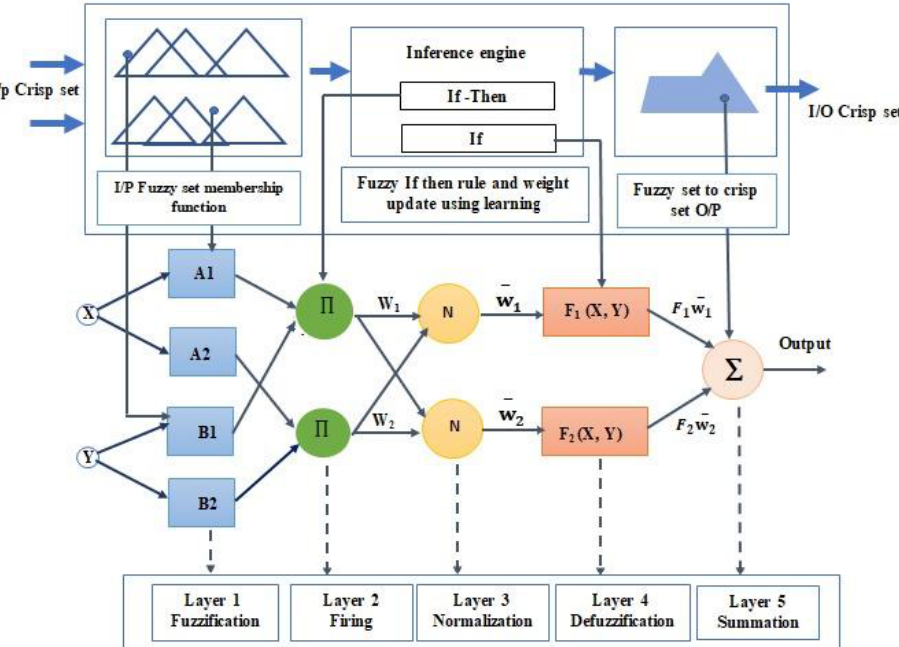
Figure 3. Proposed ANFIS structure.